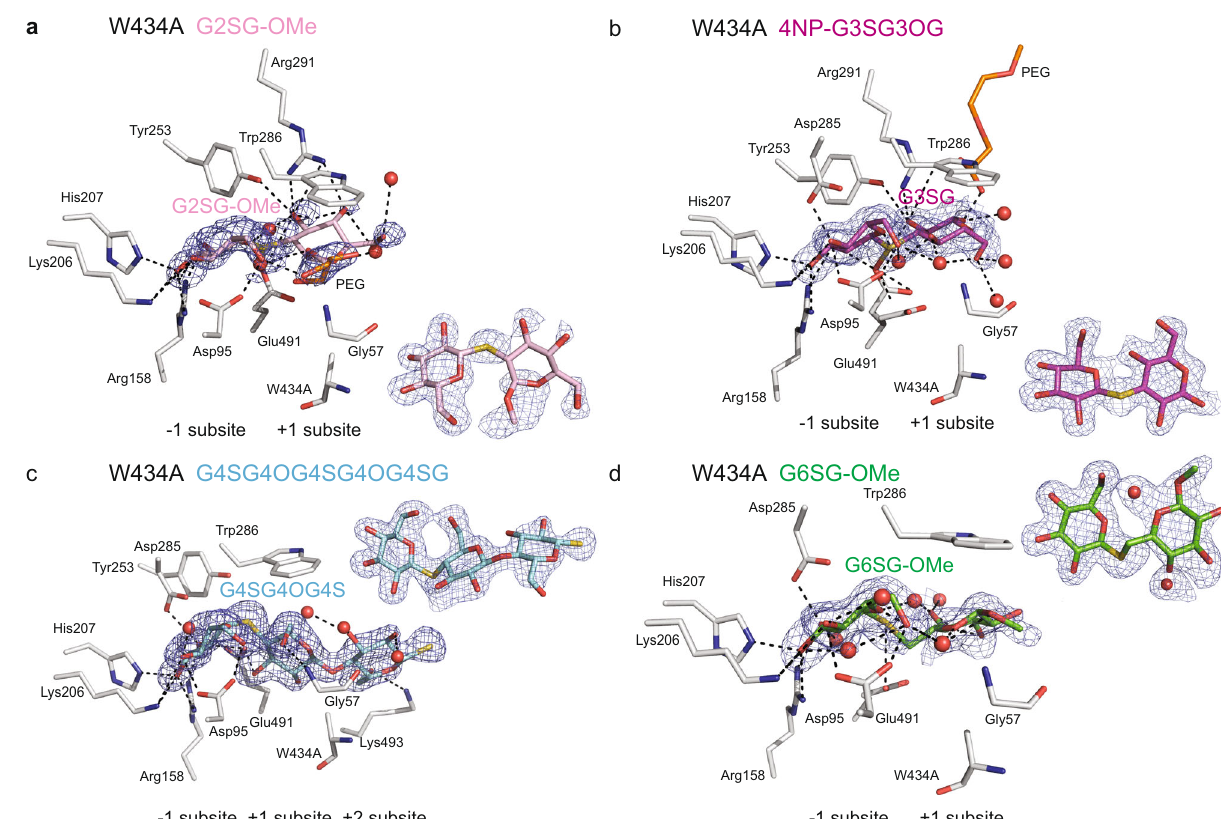
Fig. 3 | Thio-saccharide analogues are bound in the active site of the HvExoI W434A mutant. a Thio-sophoroside (G2SG-OMe, pink); b thio-laminaribioside (4NP-G3SG, magenta); c thio-cellotrioside (G4SG4OGS; cyan); and d thio- gentiobioside (G6SG-OMe, green) moieties are bound across the − 1 to +2 subsites. Panels a – d contain derived difference 2m| F o |-D| F c | electron density maps (blue) of